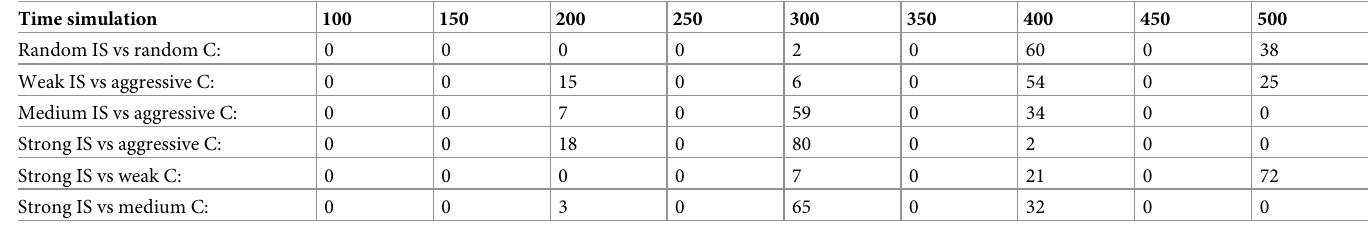
Table 3. This table shows the percentage of simulations ended in before a given number of events. The label meaning is as follows: Strong corresponds to the GnuGo simulator, Medium correspond to the SMART simulator and the Weak correspond to the MonteCarlo simulator. IS correspond to immune system and C correspond to